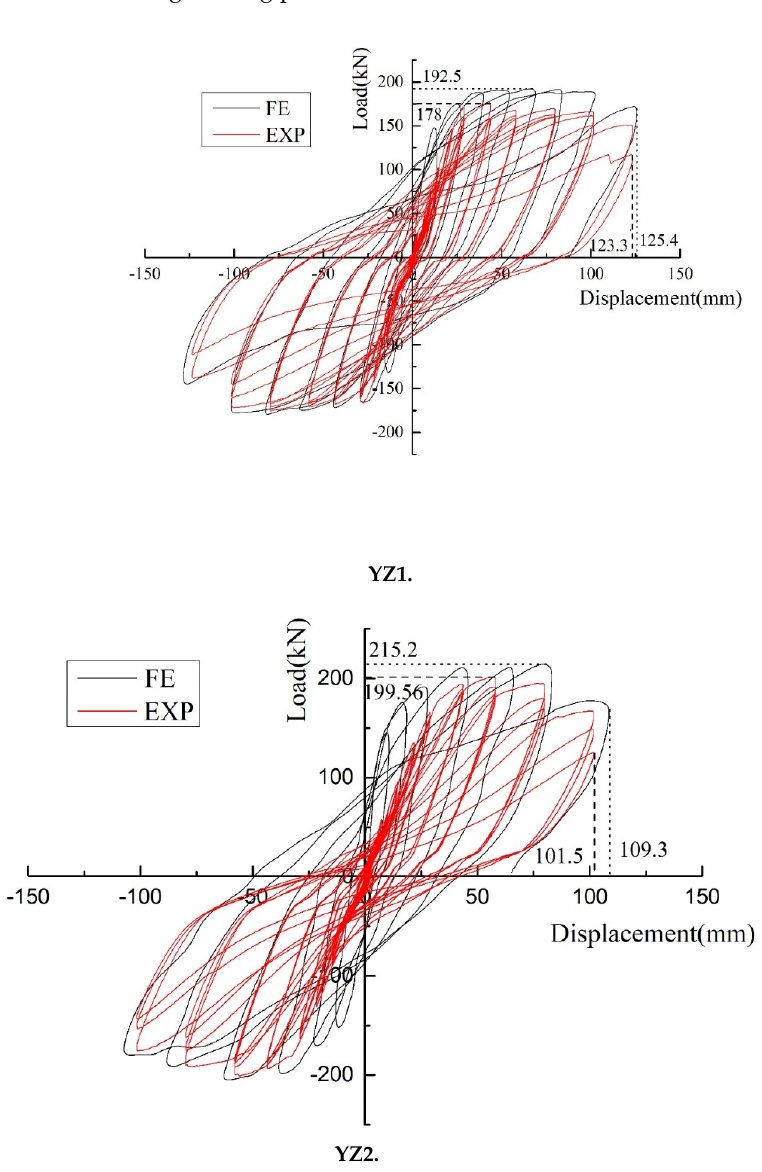
Figure 19. A comparison of finite element calculation and test results .